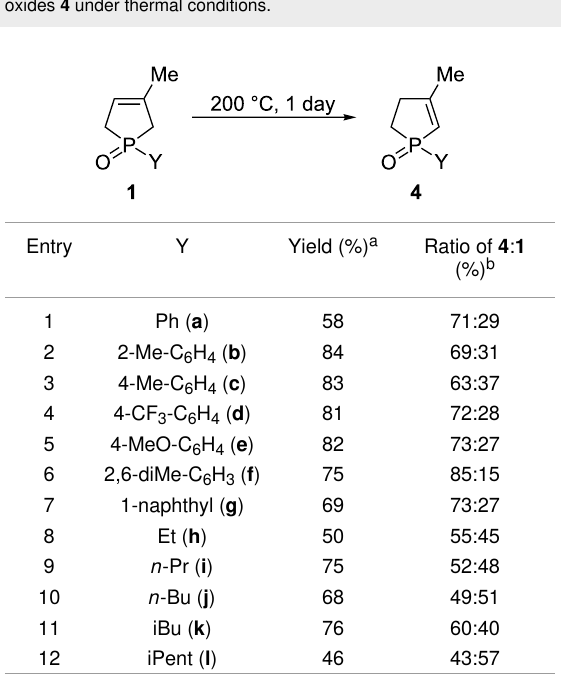
Table 3: Investigation of the isomerization of 1-phenyl- and 1-ethyl-3- methyl-3-phospholene oxides 1a or 1h to the corresponding 2-phospholene oxides 4 in the presence of Cs 2 CO 3